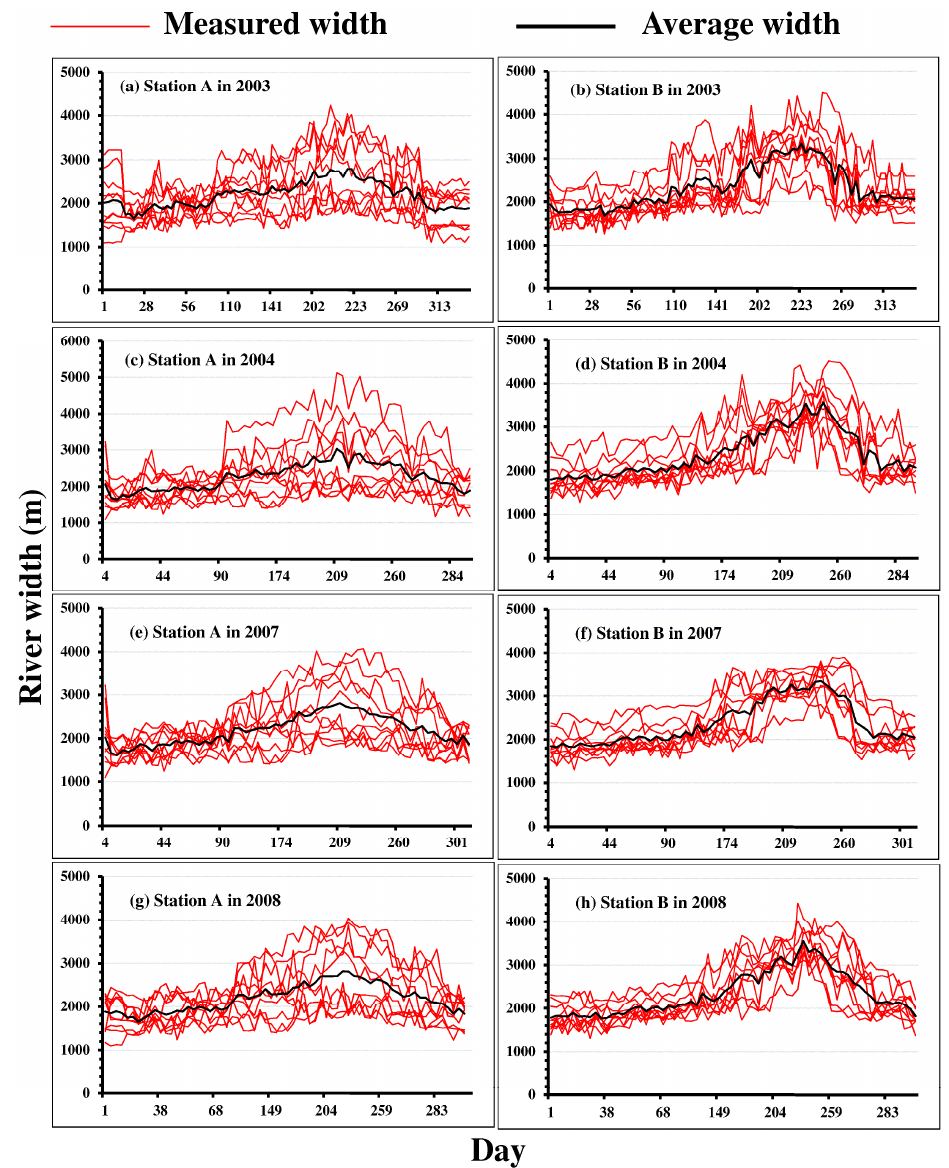
Figure 8. Demonstration of the river width changes derived using cloud-free MODIS images for the study period of 2003–2008.